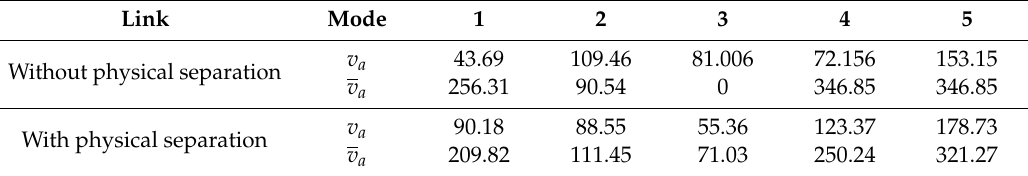
Table 2. Link flows of the nonlinear complementarity problem (NCP) for cases with and without physical separation.